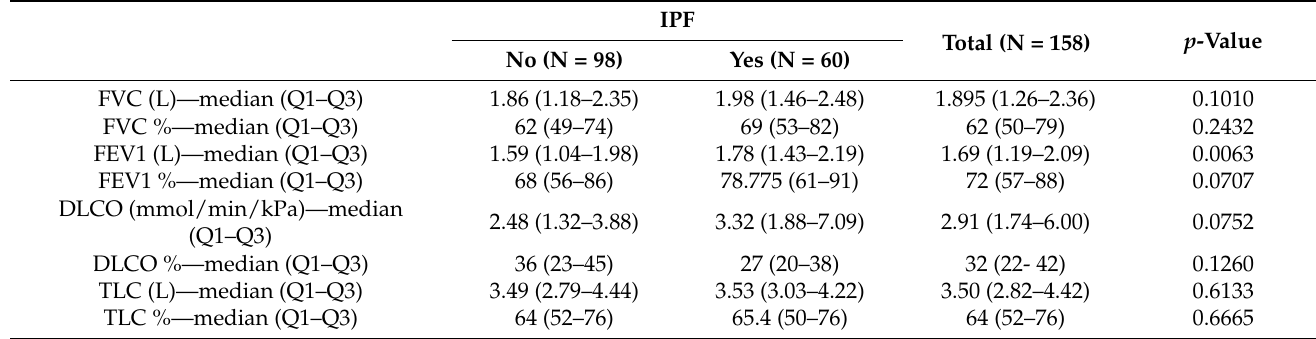
Table 2. Lung function tests in stability.